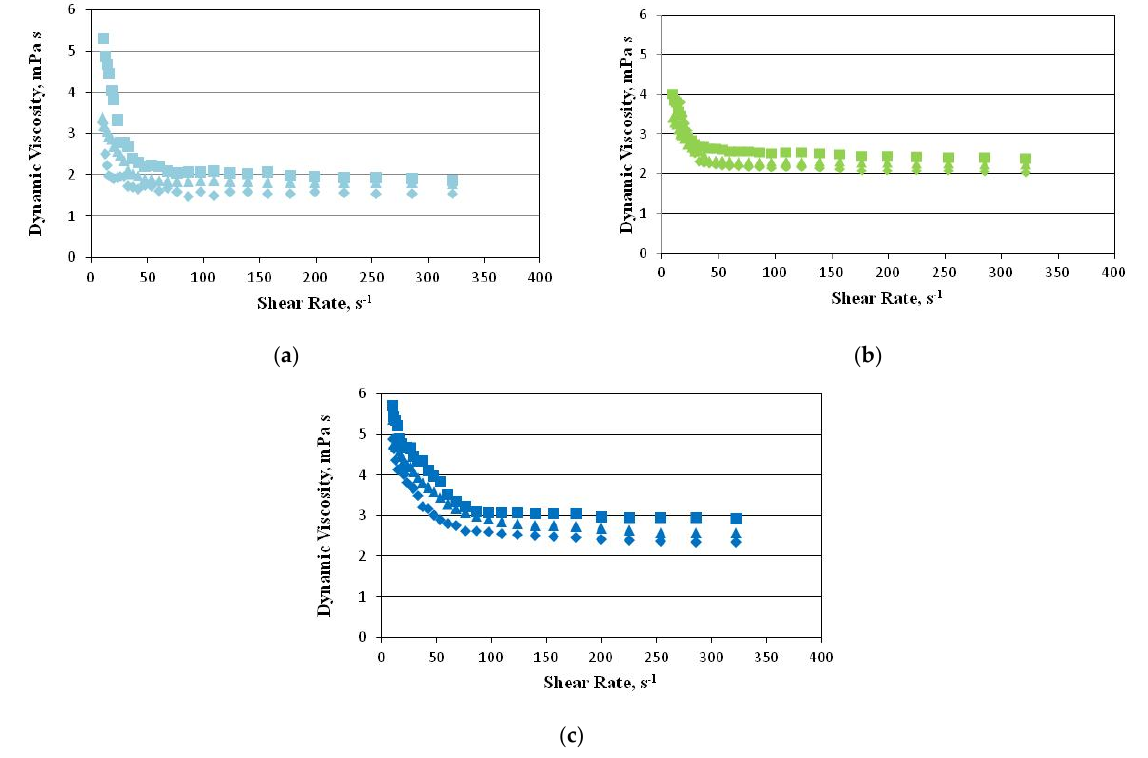
Figure 5. The dependence between the dynamic viscosity and the shear rate of the model O/W emulsions: ( a ) HSO in water; ( b ) HSO in Nebudose; ( c ) HSO in water with AHE. ◆ —1%; ■ —2%; ▲ —5%.